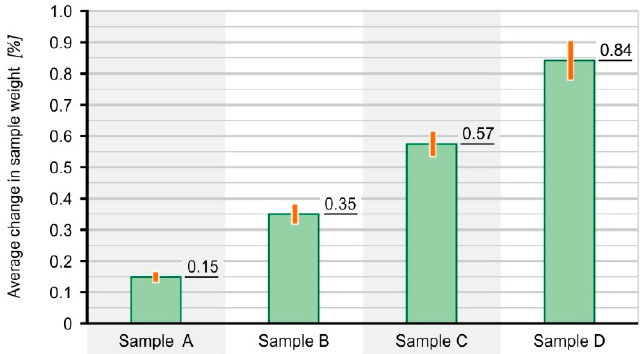
Figure 4. Results of water absorption by composite samples.